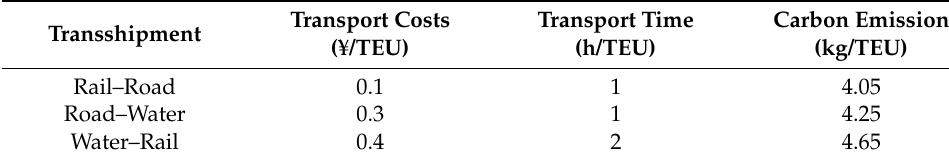
Table 4. Transshipment costs between different transportation